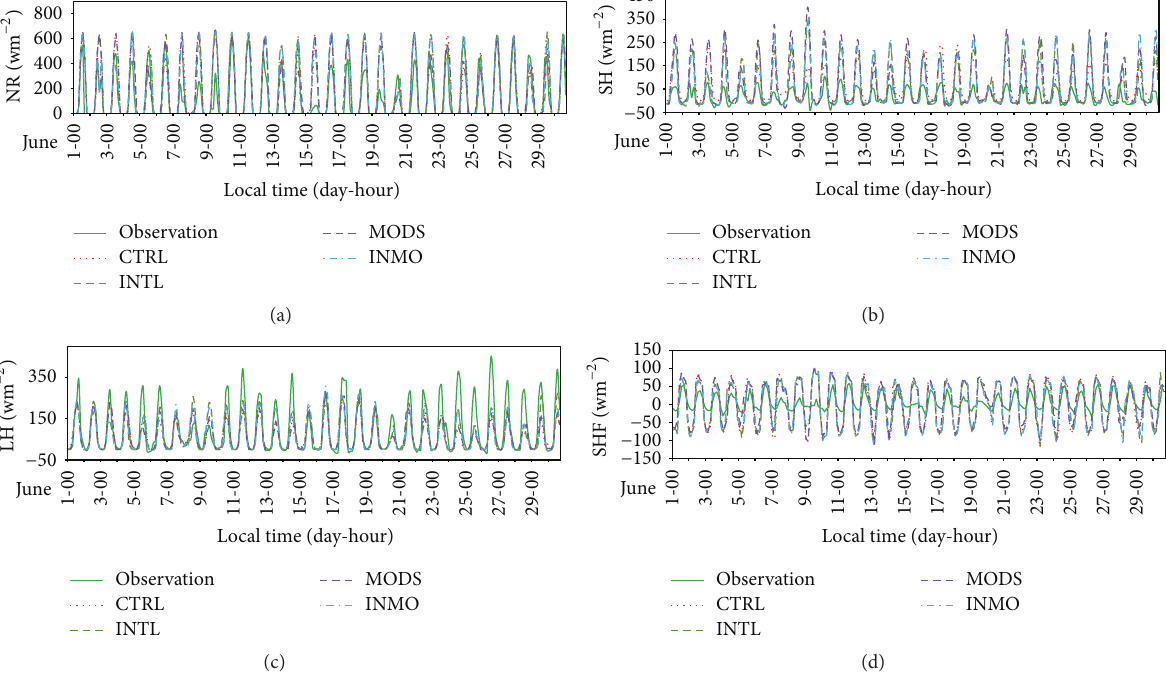
Figure 4: Comparison of modeled and observed surface flux at Arou station: (a) net radiance (NR), (b) sensible heat flux (SH), (c) latent heat flux (SH), and (d) soil heat flux